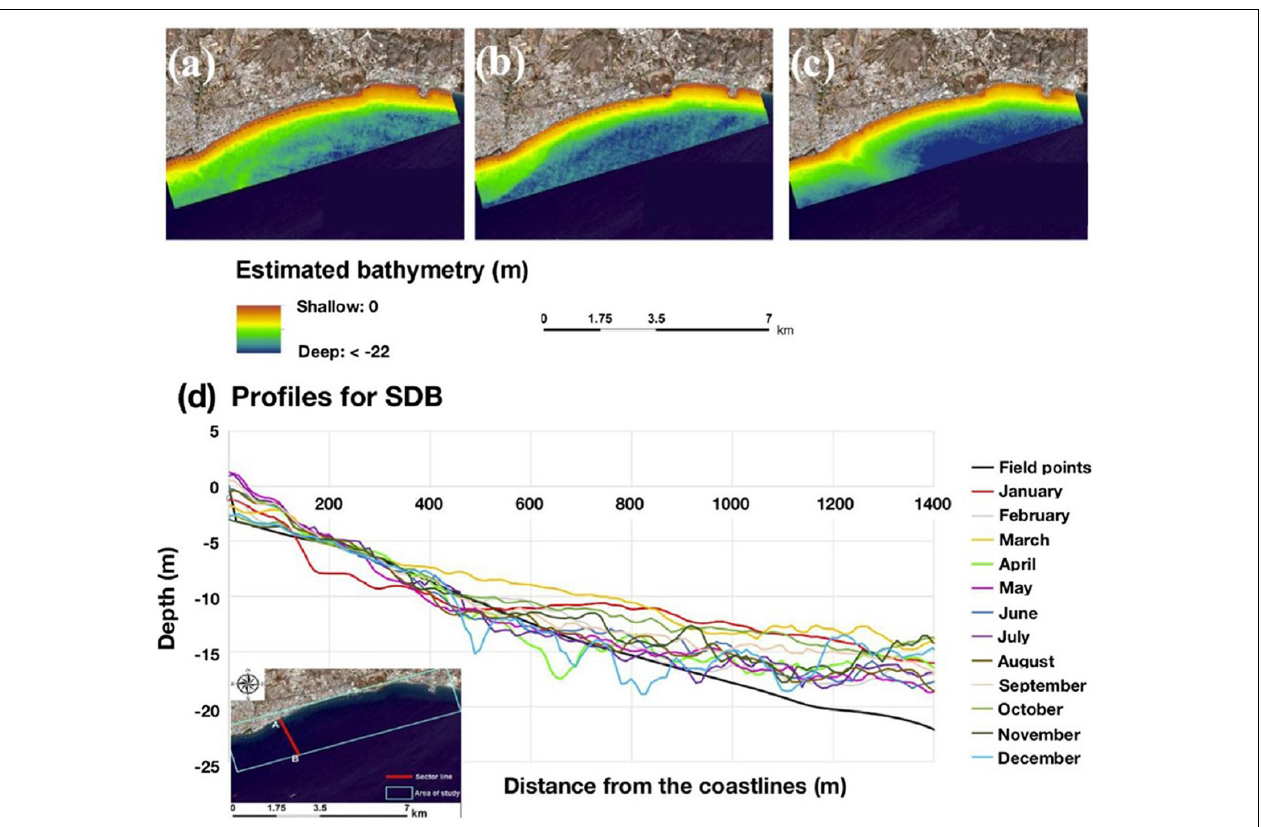
FIGURE 1 | Satellite-derived bathymetry (SDB) from Sentinel-2 multispectral optical data in (a) January 2018, (b) February 2018 and (c) March 2018 for depth shallower than 22 m over a coastal area of southern Cyprus. The monthly evolution of a bathymetric profile (shown in the lower inset) is shown in panel (d) from April 2017 to March 2018 with Sentinel-2 data. Field points correspond to LIDAR data acquired in 2014. Adapted from Evagorou et al.